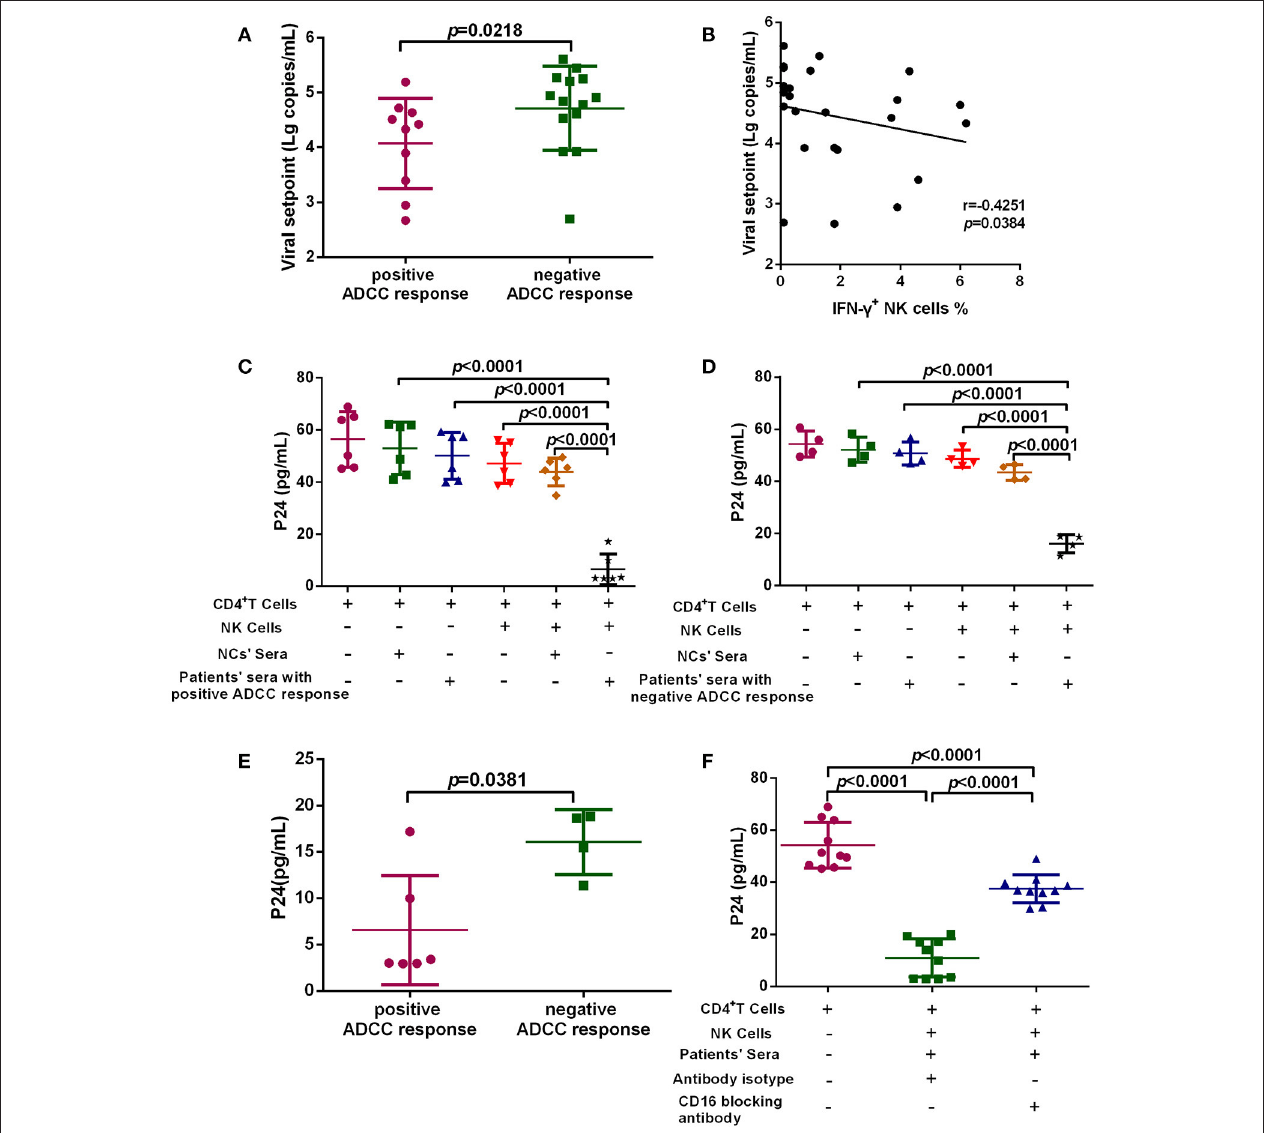
FIGURE 3 | ADCC responses suppress HIV infection and influence viral set point levels. (A) Comparison of viral set points of positive ( n = 10) and negative ( n = 14) ADCC responses in HIV-infected subjects with viral set point. (B) Correlation analysis between the level of ADCC responses and viral set points ( n = 24). Spearman’s rank test was used to correlate the data and p < 0.05 was considered significant. (C) Inhibition of viral infection by ADCC responses with sera of positive responses ( n = 6) from PHI group and healthy donors’ sera (negative control). (D) Inhibition of viral infection by ADCC responses with sera of negative response ( n = 4) from CHI group and healthy donors’ sera (negative control). (E) Comparison of the inhibition of viral infection by ADCC response with serum of positive ( n = 6) and negative ( n = 4) responses from PHI group. (F) The effect of anti-CD16 blocking antibody on ADCC-mediated inhibition of viral infection by evaluation of responses in individuals with PHI ( n =